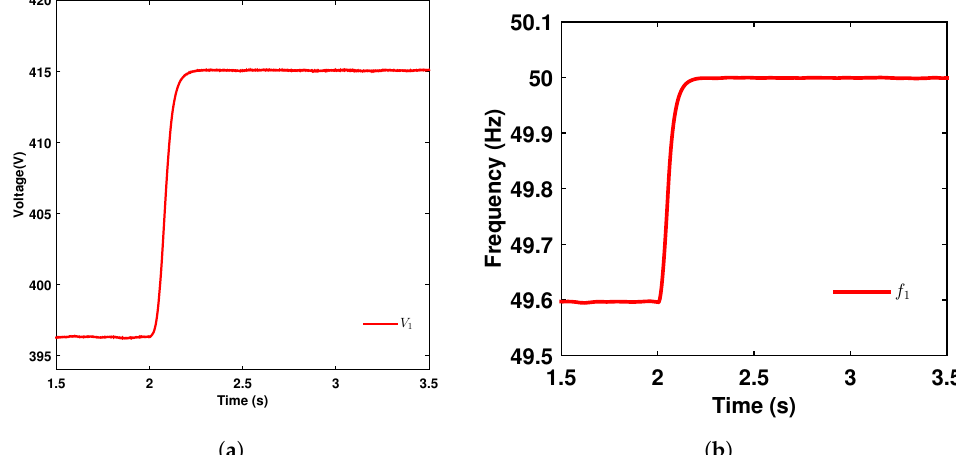
Figure 10. Performance with link delay. ( a ) Voltage under link delay τ d = 100 ms. ( b ) Frequency under link delay τ d = 100